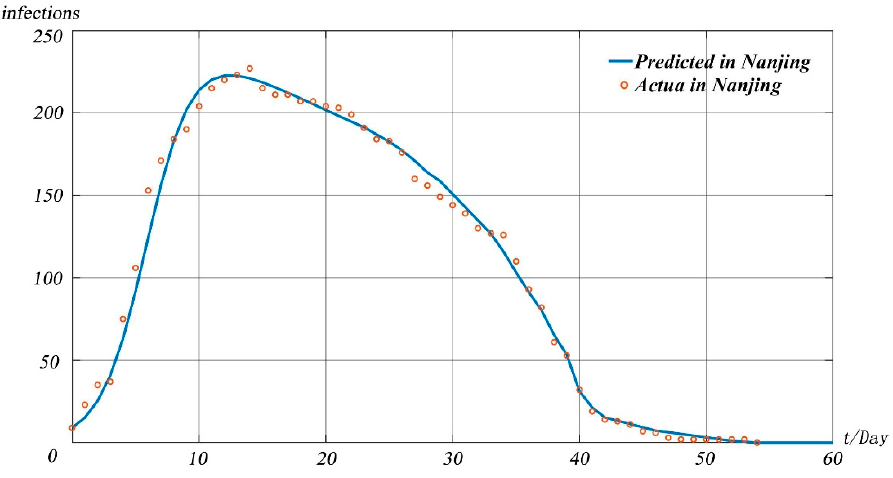
Figure 10. The model-predicted infectious individuals in Nanjing.